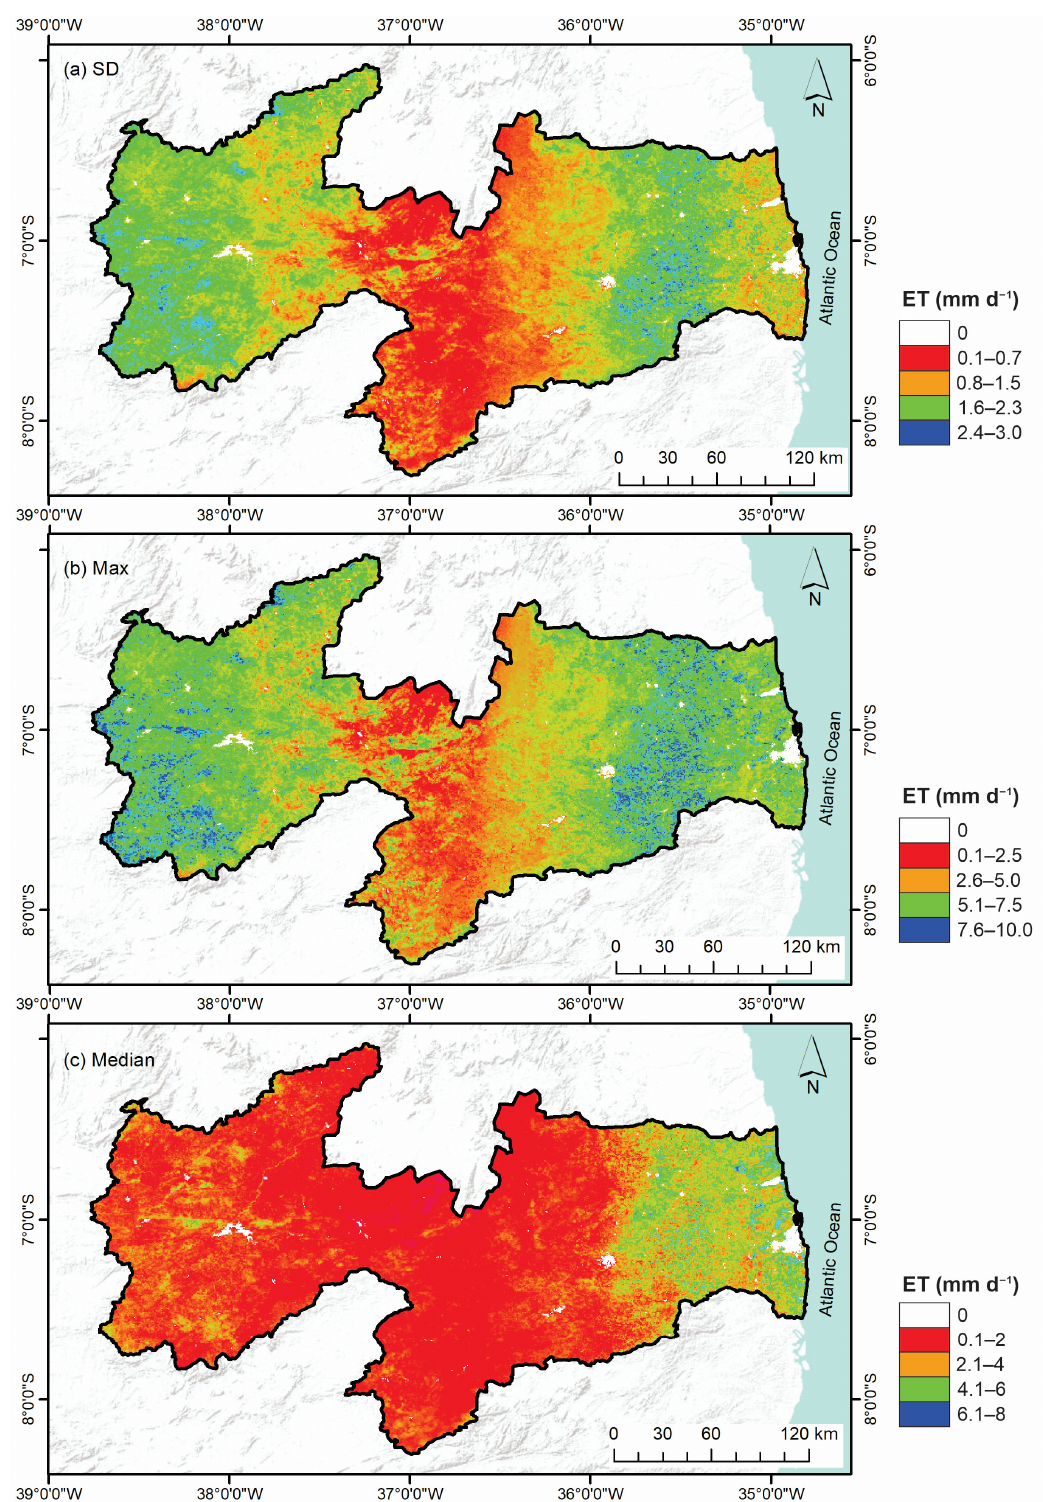
Figure 6. Statistical analysis (standard deviation—SD, Maximum—max, and median) of the ET for the state of Paraíba in 2013 derived from the product MOD16A2.